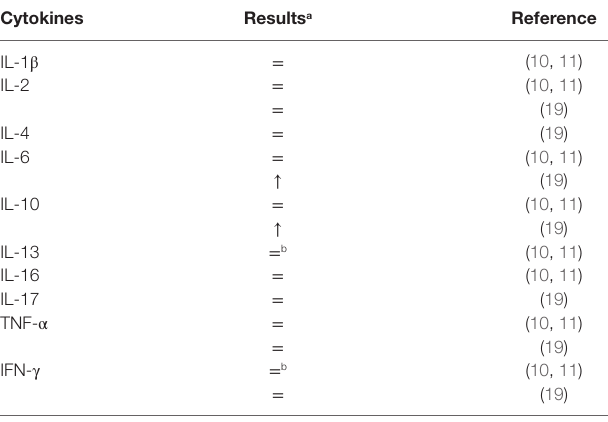
taBLe 2 | Cytokines blood level comparison between ADHD patients and controls.